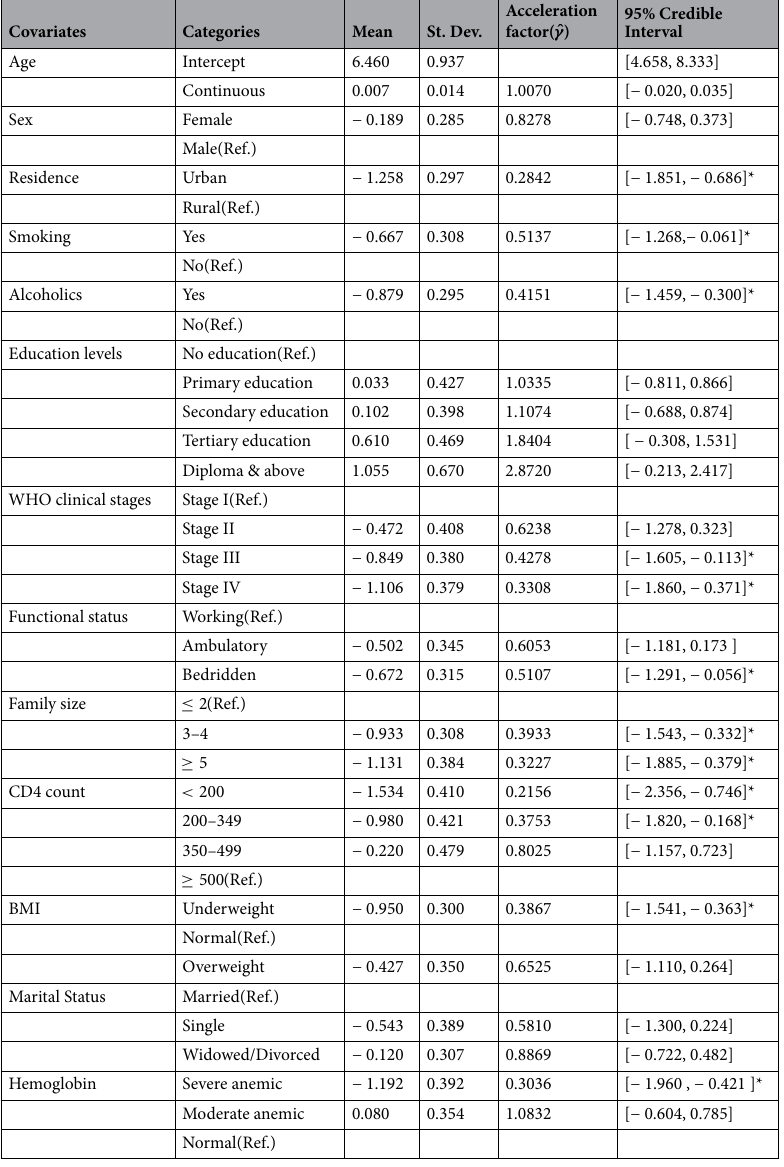
Table 3. Summary results of Bayesian Loglogistic AFT